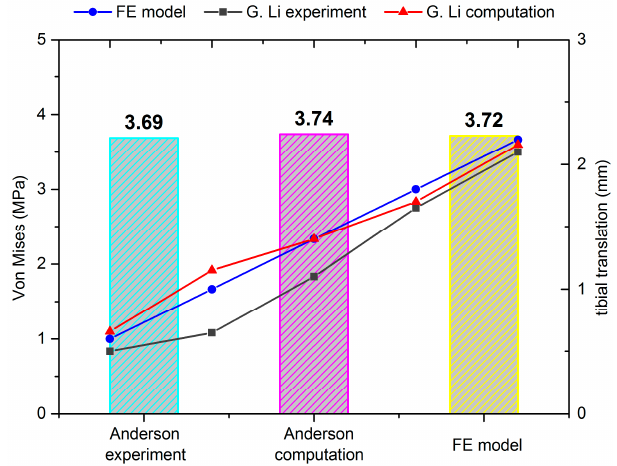
Figure 2. Validation of finite element model via comparison to existing studies. The bottom axis, left axis, and histogram show the comparison with Anderson’s results to validate the biomechanical property of the ankle, while the top axis, right axis, and line chart present the comparison with Li’s results to validate the biomechanical property of the knee.